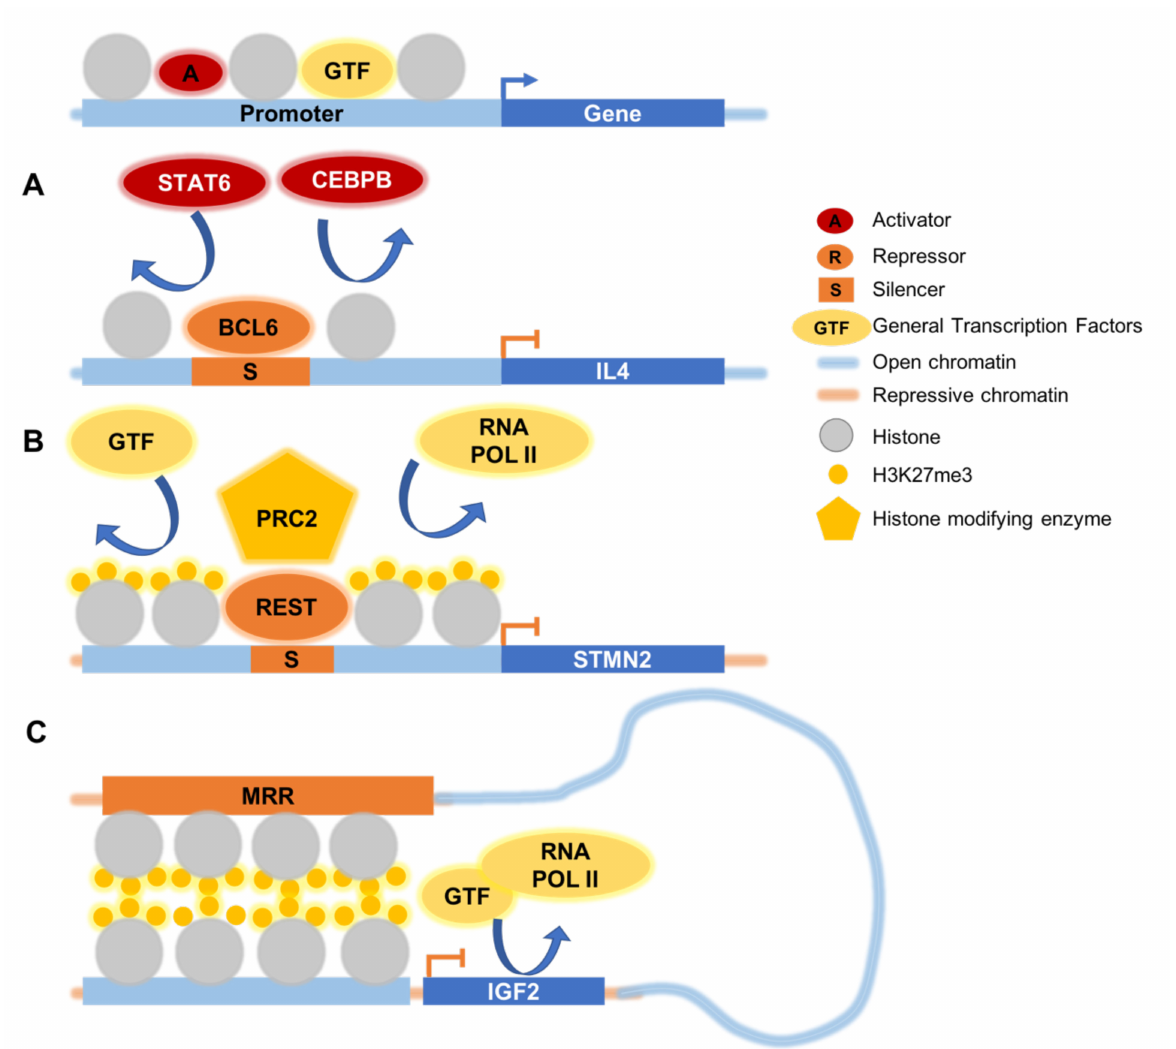
Figure 2. Mechanisms for silencer repression. Silencers can repress gene expression in two ways: ( A ) One way is to compete with activators or general transcription factors (GTF) for binding sites. For example, BCL6 competes with STAT6 and CEBPB for binding at the IL4 promoter to prevent transcription [36]. ( B ) Another way is to generate a repressive chromatin environment, for example by methylating the histones at the gene promoter, thereby preventing the binding of activators and transcriptional machinery. For example, the REST complex binds at the promoter of STMN2 [37], recruiting the PRC2 complex and depositing H3K27me3. ( C ) Silencers can interact with linearly distant gene promoters through chromatin looping, to perform their repressive functions. The IGF2 promoter interacts with a distal H3K27me3-rich region (MRR) and forms a repressive